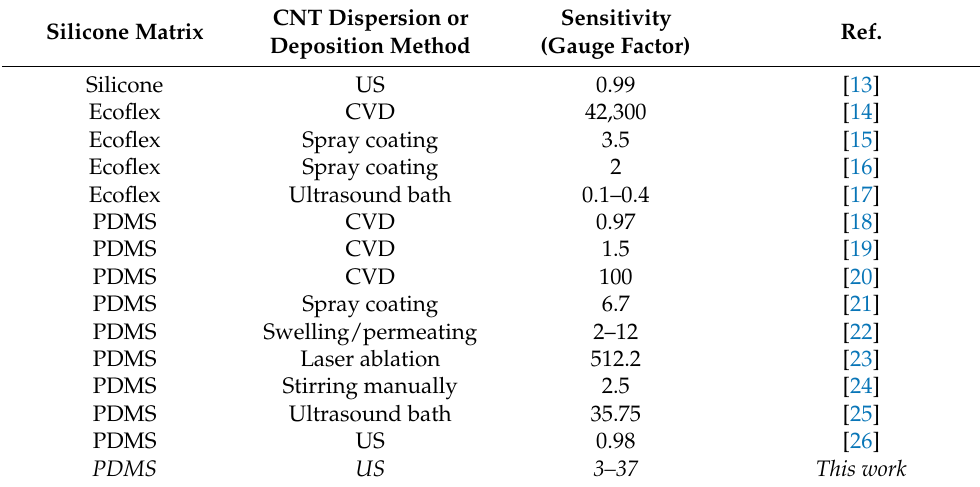
Figure 7. Cycling response of the 0.4 wt.% CNTs sensor by ultrasonication at 10%, 5%, and 2% strain levels. ( a ) Electrical response under 300 cycles; ( b ) detail of the first 5 cycles of the electrical response; and ( c ) mechanical response under 300 cycles. Table 2. The sensitivity and CNT dispersion/deposition method of strain